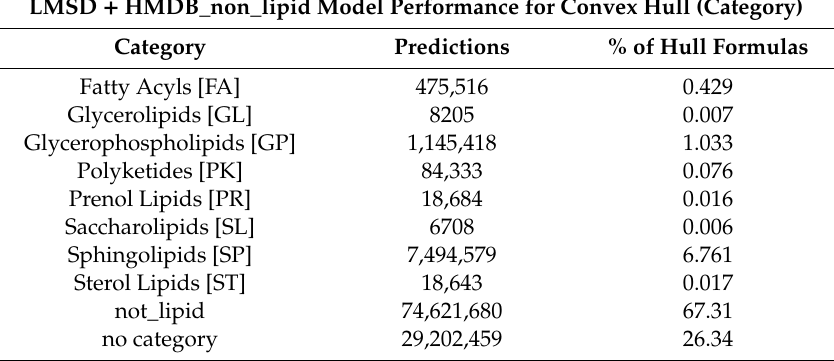
Table 3. LMSD + HMDB_non_lipid model performance for convex hull (category).